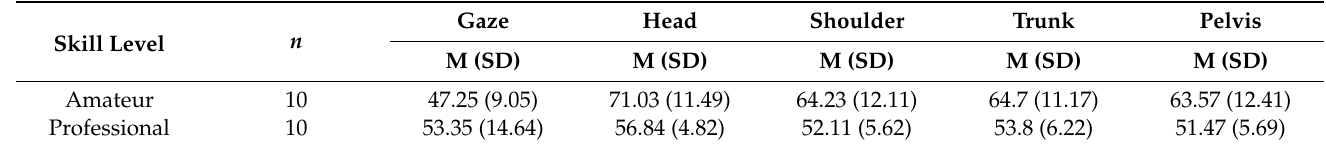
Table 1. The mean (and SD) maximum angular velocity timing of each segment.